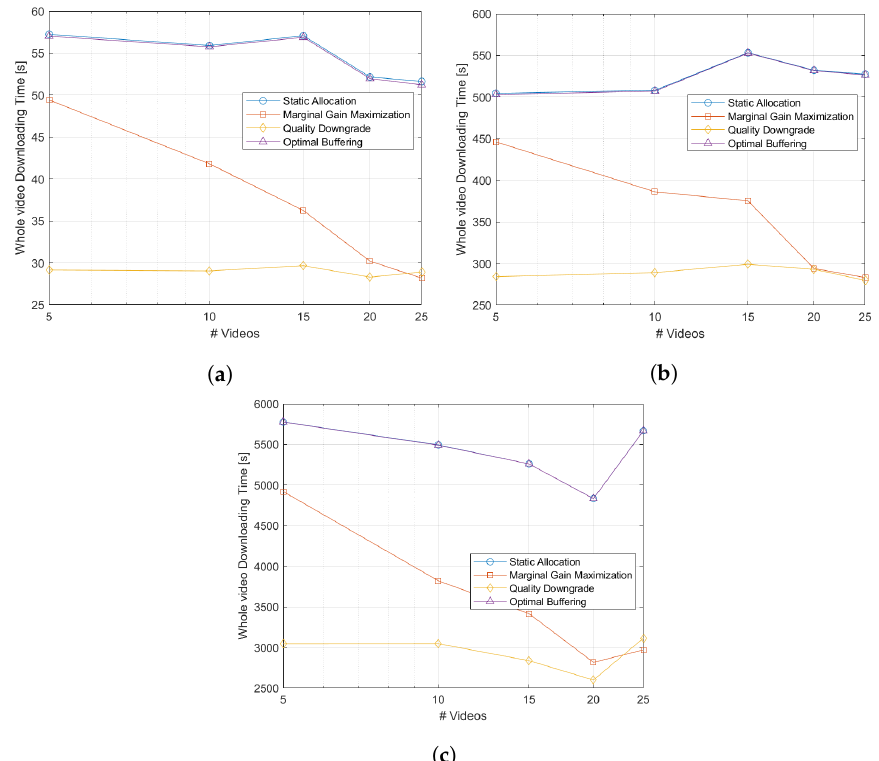
Figure 8. Average video downloading time with variable number of videos. ( a ) Short videos. ( b ) Medium videos. ( c ) Long